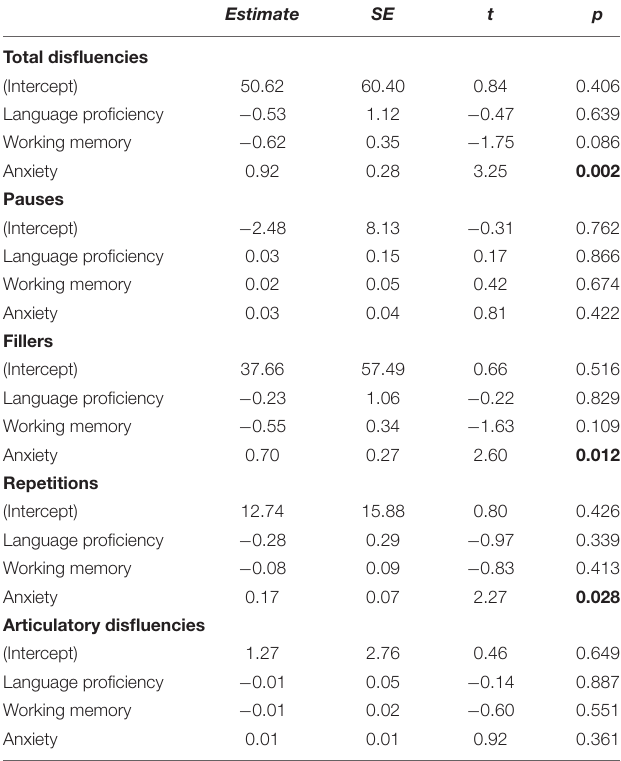
TABLE 3 | Different types of disfluencies as a function of the cognitive factors (significant p -values in